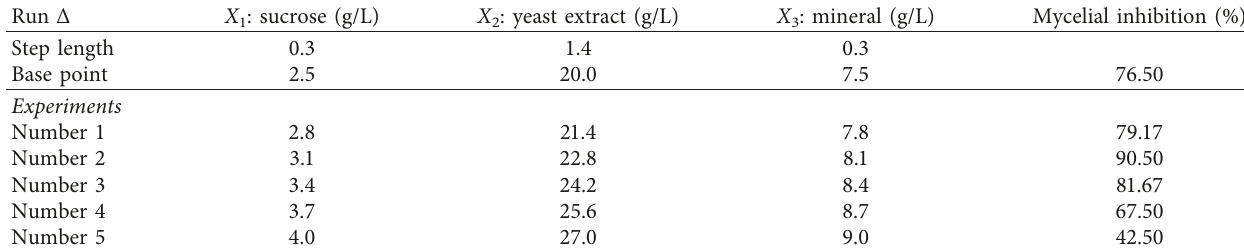
Table 3: Steepest ascent experiment design.